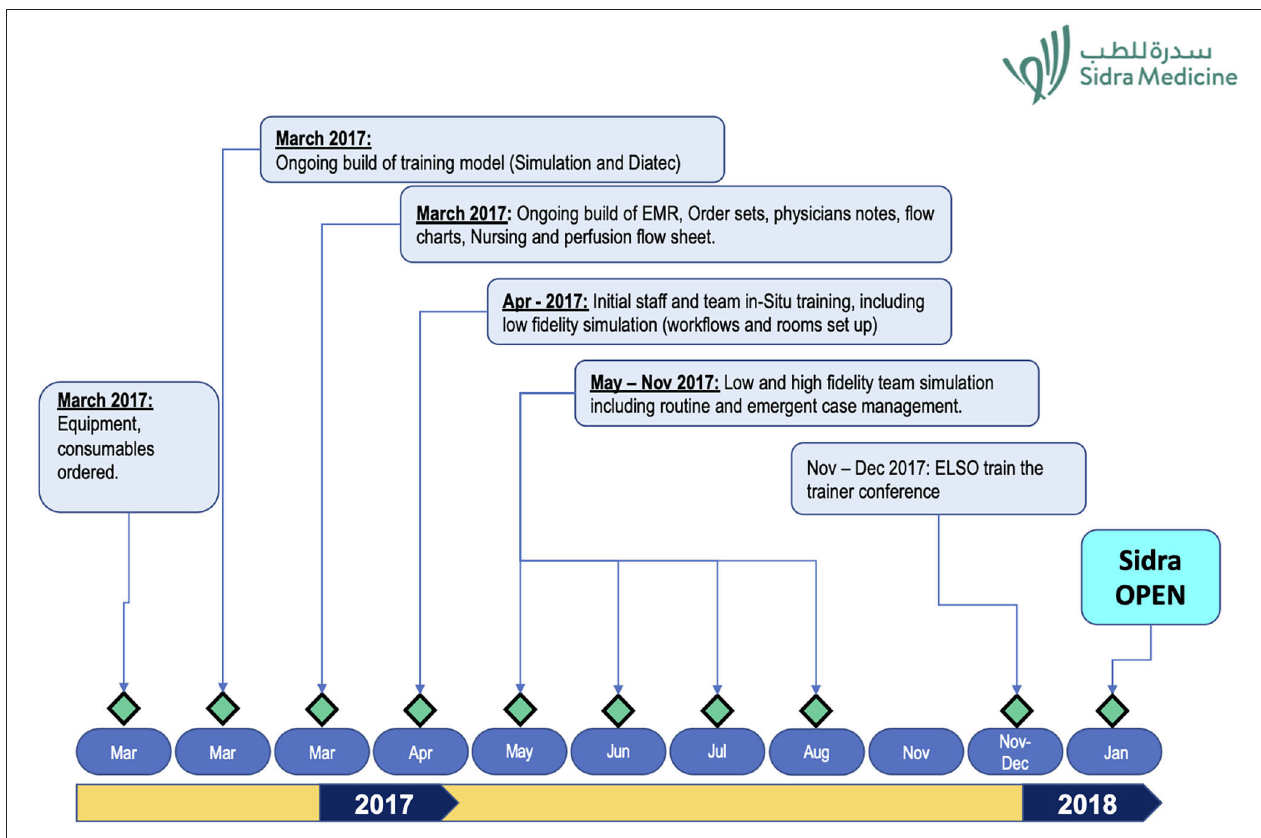
FIGURE 1 | Sidra ECMO service